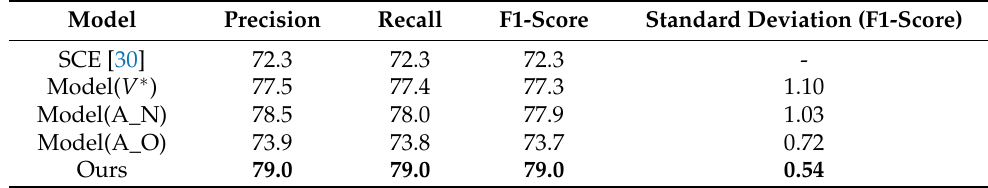
Table 8. Ablation experiment results. V ∗ represents the contextual video features collected by Castro et al.